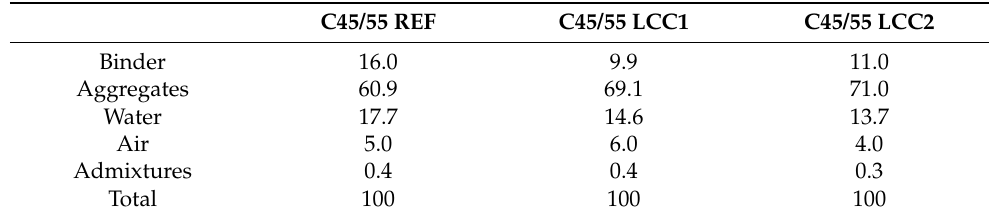
Table 1. Concrete proportions in volume (%).